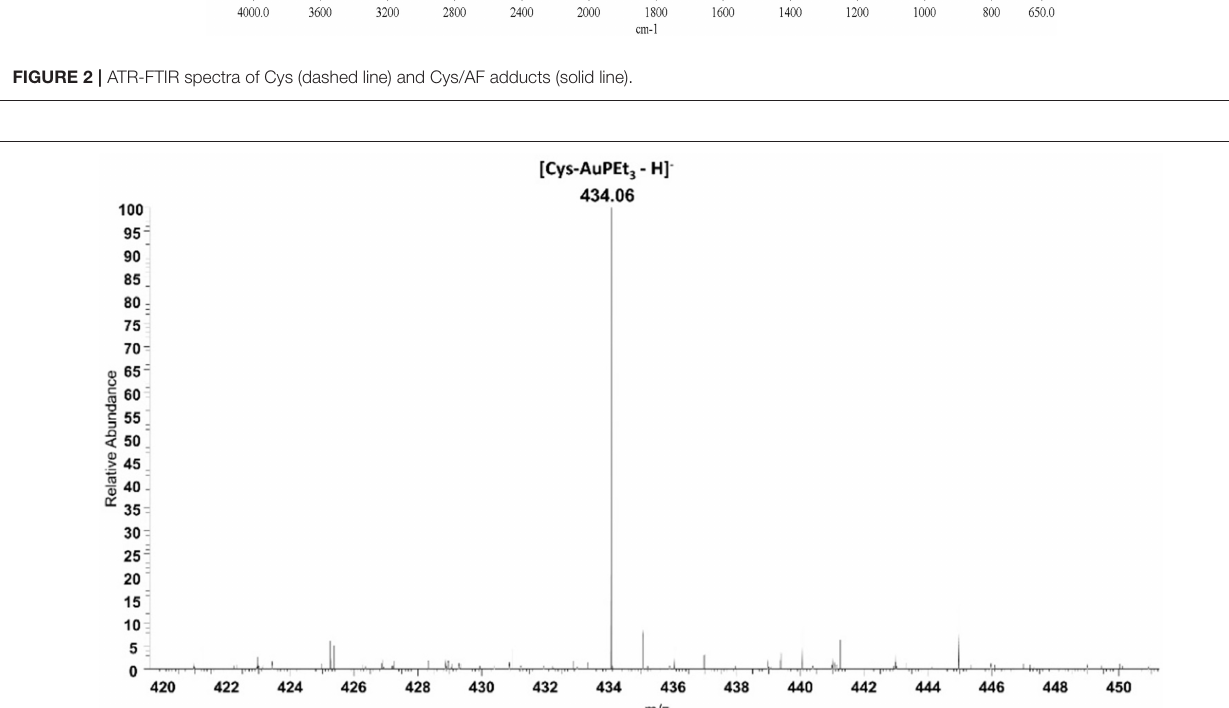
FIGURE 3 | ESI mass spectrum of auranofin (10 − 5 M) incubated for 24h at 37 ◦ C with cysteine (1:1 metal to amino acid ratio), in ammonium acetate buffer 500mM pH = 6.8 in presence of 50% MeOH.